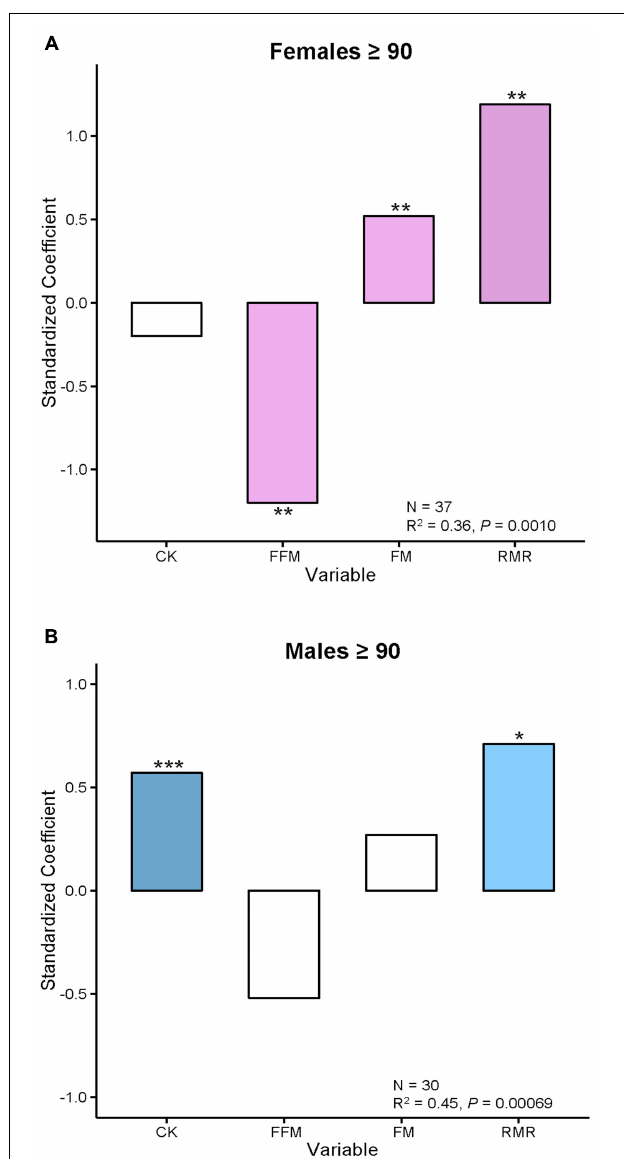
FIGURE 1 | Body composition and creatine kinase levels are associated with FI 34 in females and males, respectively. (A) Female and (B) male nonagenarians were compared. FI 34 is the outcome variable presented as a standardized coefficient in multiple linear regressions. The explanatory variables are CK, FFM, FM, and RMR. The sample size ( N ) and the coefficient of determination ( R 2 ) with p -value are shown. ∗ p < 0.05; ∗∗ p < 0.01; ∗∗∗ p < 0.001, for the standardized coefficients for each variable. Based on data from Kim et al.